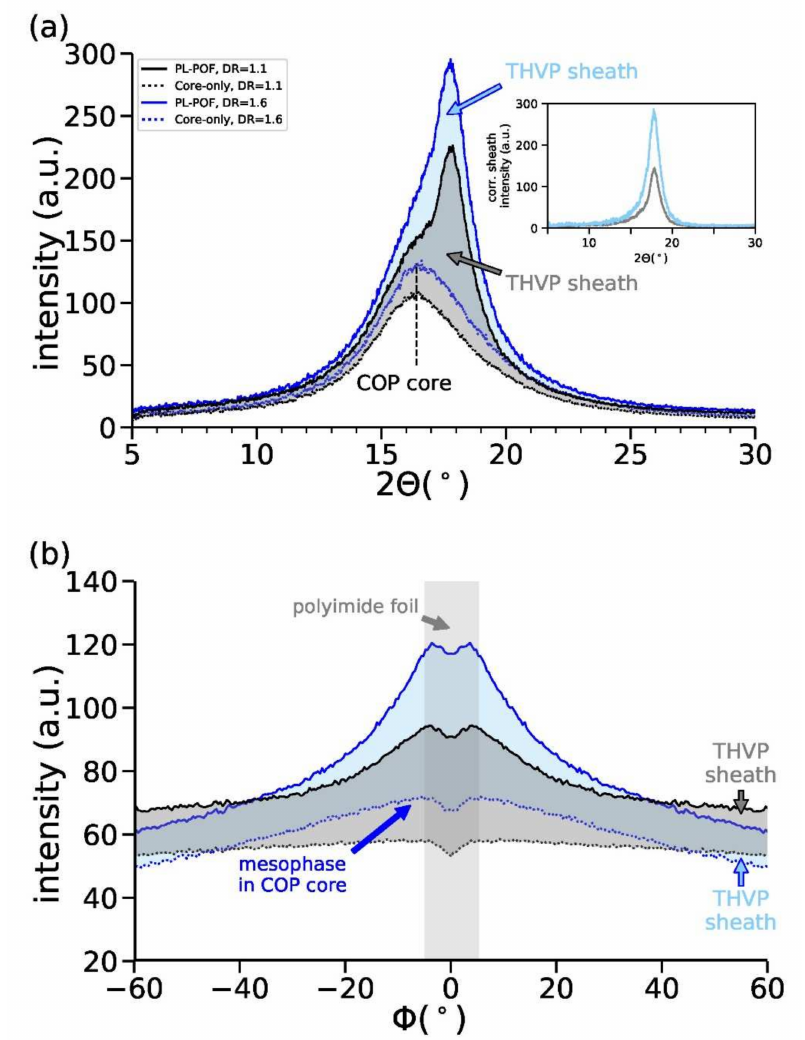
Figure 8. ( a ) Equatorial WAXD profiles and ( b ) azimuthal profiles of PL-POFs and corresponding core-only fibers. The inset in ( a ) shows the corrected equatorial intensity of the sheath material, which is obtained by subtracting the intensity of the core-only fiber from the PL-POF. The correction is explained in the main text. The intensity in the central region of ( b ), around φ = 0 ◦ , is slightly decreasing due to a polyimide foil that holds the